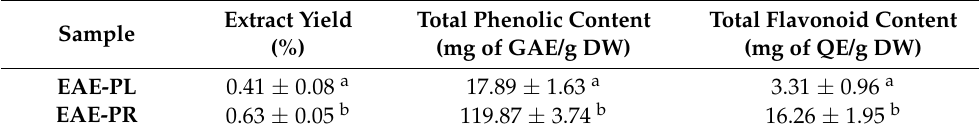
Table 1. Analysis of the total yield, total phenolic content, and total flavonoid content of the EAE-PL and EAE-PR. The superscripts represent significance ( p < 0.05) among samples.